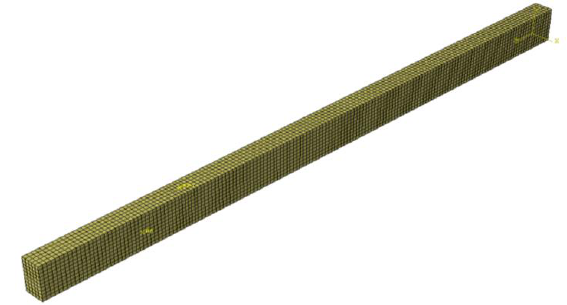
Figure 5. Mesh detailing of the reference beam model in FE